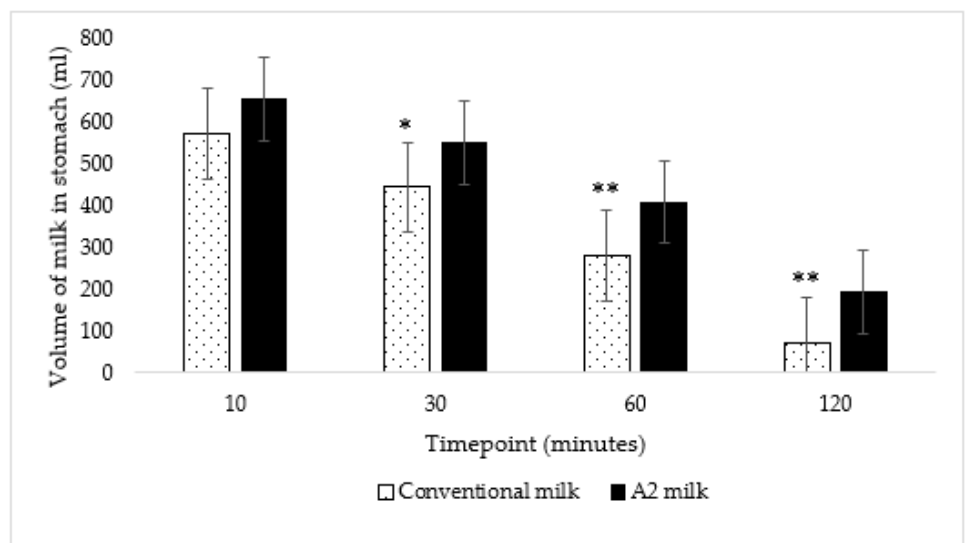
Figure 4. The volume of A2 milk in the stomach was significantly lower at 30, 60 and 120 min as compared to the volume of conventional milk in the stomach: * p = 0.01 at 30 min and ** p < 0.01 at 60 and 120 min; p = 0.05, p = 0.01, p = 0.002, and p < 0.001 at 10, 30, 60 and 120 min, respectively. The vertical lines in the graph indicate the standard error.